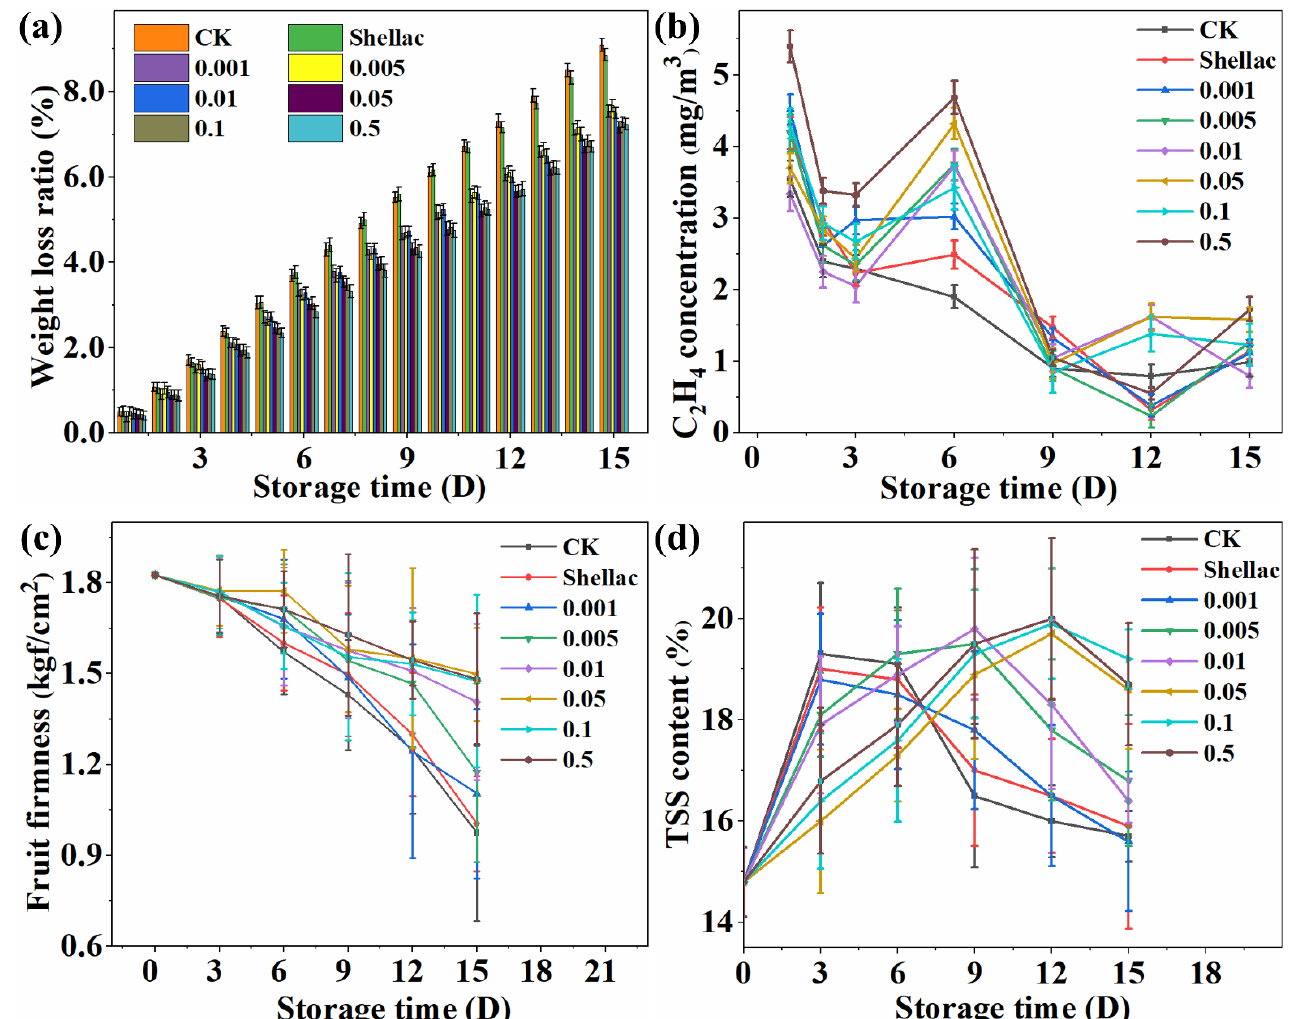
Figure 6. Weight loss ratio ( a ), C 2 H 4 concentration ( b ), Fruit firmness ( c ), and total soluble solids content ( d ).